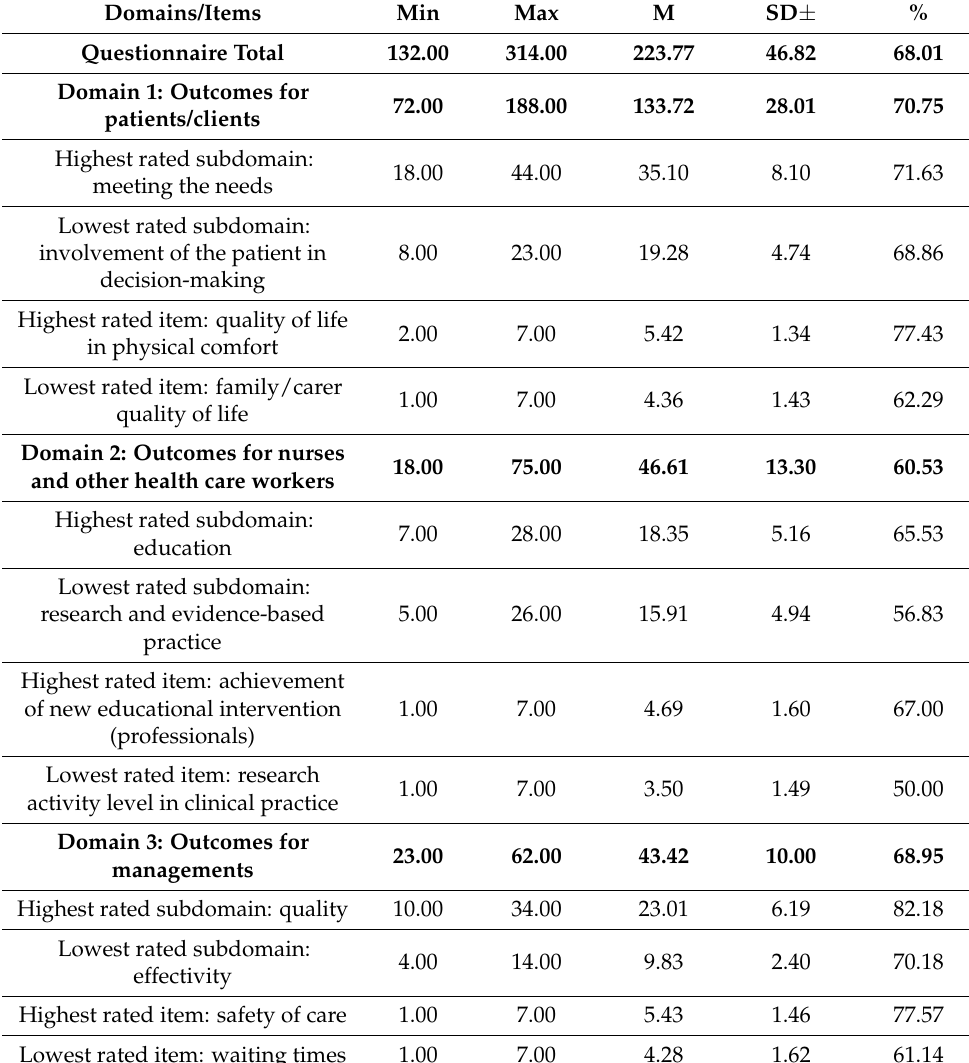
Table 2. Results of the questionnaire (domains and